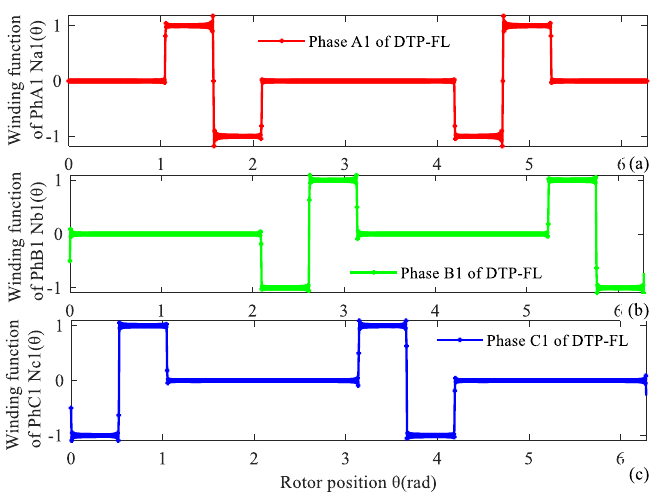
Figure 11. Winding function of first group of DTP-FL winding. ( a ) A1, ( b ) B1, ( c ) C1.